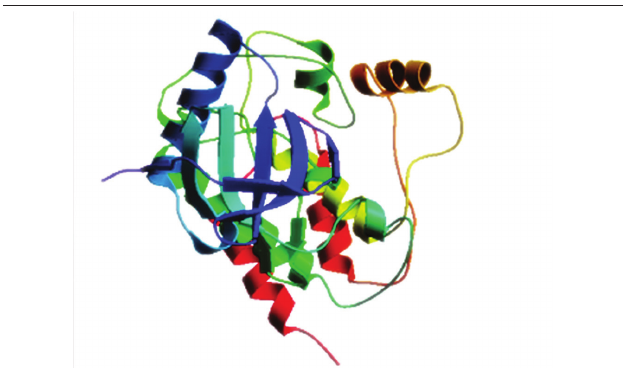
figurE 18 − Serine/threonine-protein kinase B-raf [ Homo sapiens ]